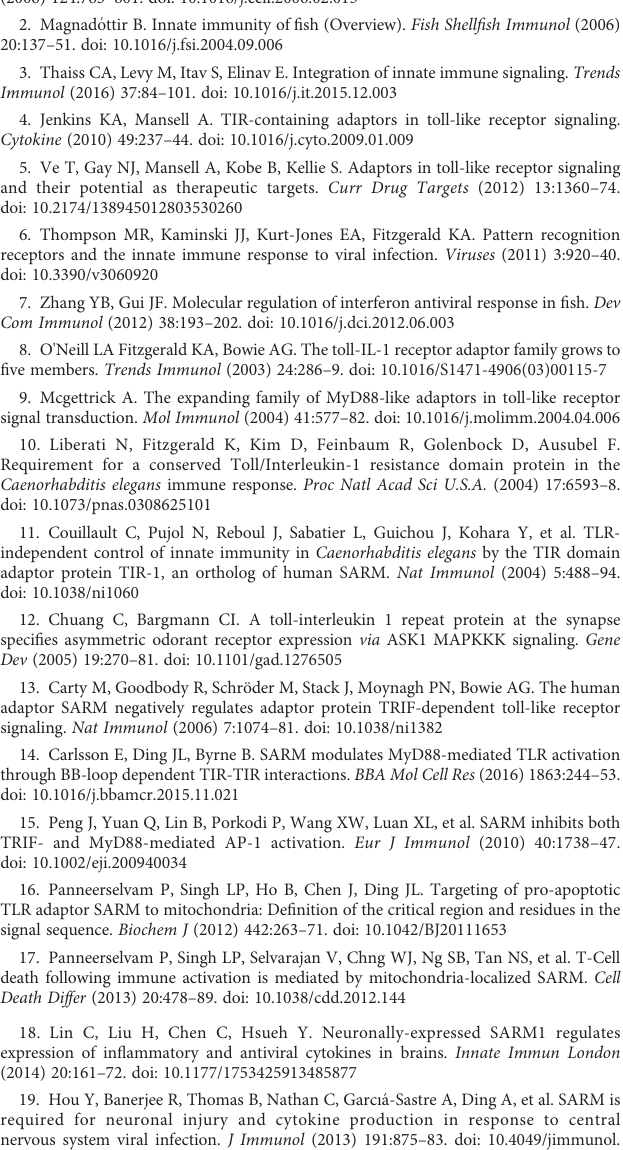
SUPPLEMENTARY FIGURE 1 Multiple alignment of the amino acid sequence of Lc- SARM with those of other vertebrate SARM. Comparison of Lc -SARM with other vertebrate SARM by using Clusta X and GeneDoc program. All the sequences share the same amino acid residue are shown in the black shaded areas, and the conservative and semi- conservative amino acid substitutions are represented in the gray and light gray shaded areas, respectively. The ARM domain, two SAM domains, and the TIR domain are indicated with black